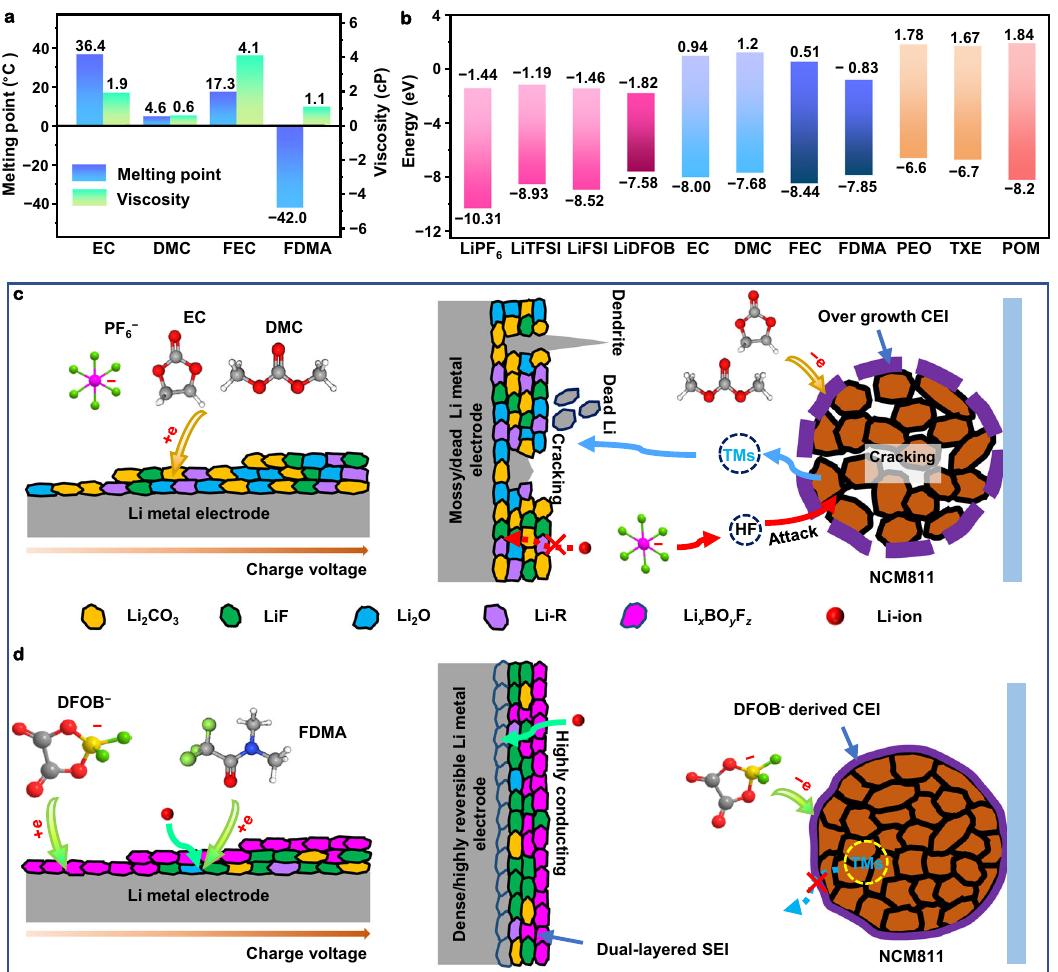
Fig. 1 | Design of polymer electrolytes for low-temperature Li metal batteries. a Comparison of the melting points and viscosity (25°C) of various solvents 32 . b HOMO and LUMO energies for commonly used Li salts, solvents, TXE monomer, PEO, and POM polymers. c Schematic representation of the solid electrolyte interphase (SEI) formed on the Li metalelectrode(left) and degradation processes happening in a Li||NCM811 cell (right) using a non-aqueous carbonate-based